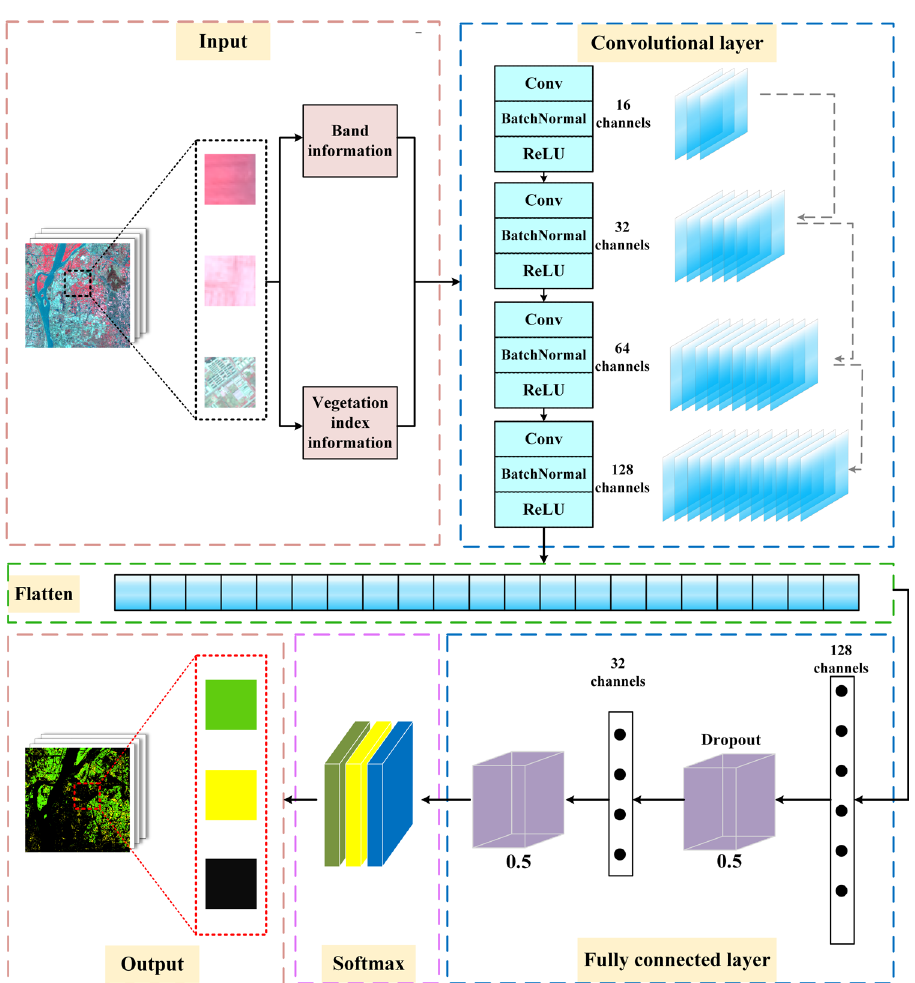
Figure 9. Overall architecture diagram of the CNN network.